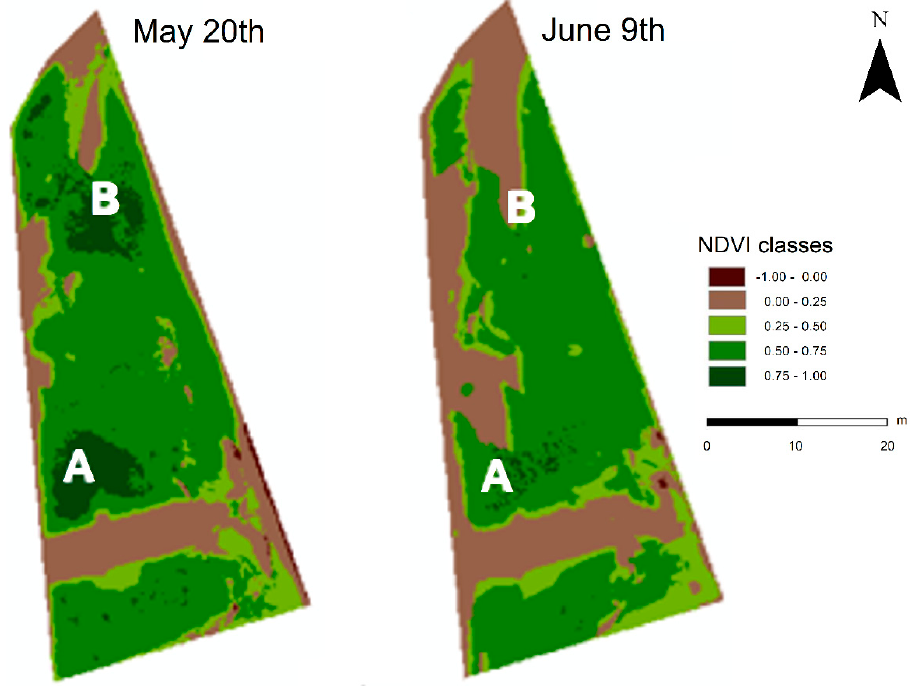
Figure 7. NDVI from the urban green area number 33 observed in: 20 May and 9 June.